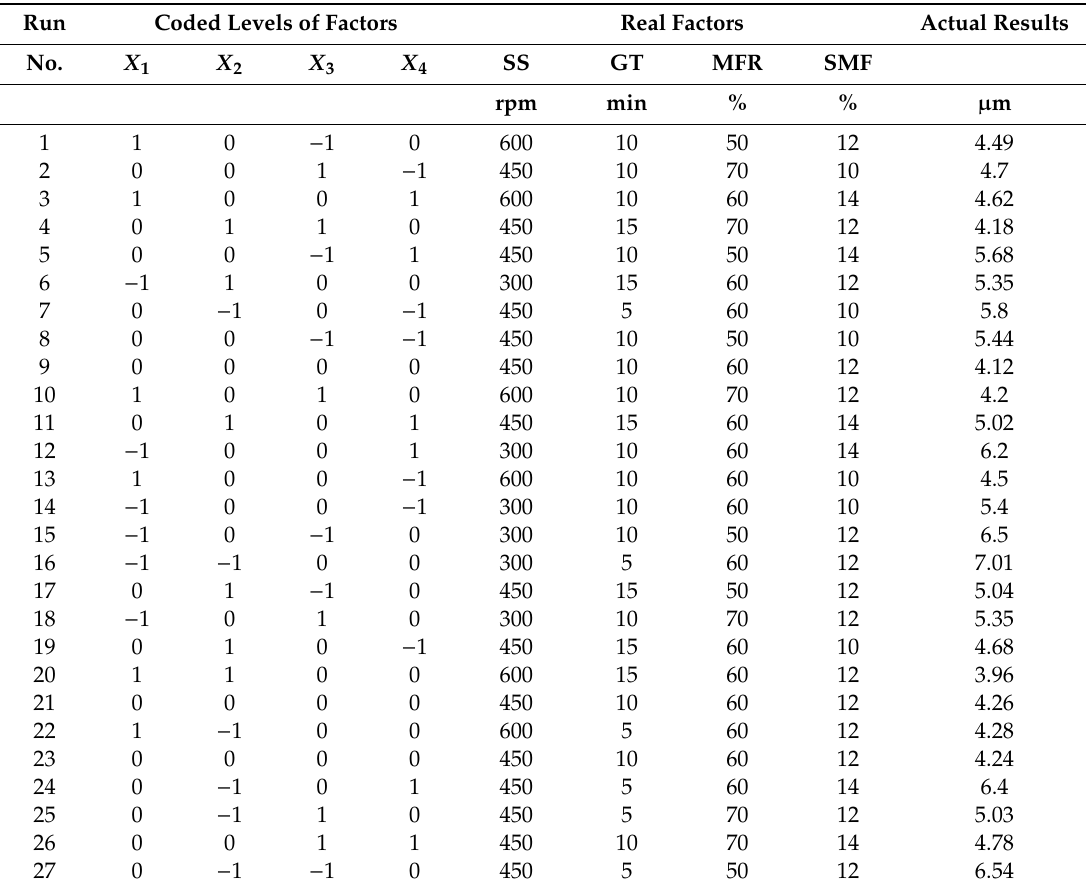
Table 3. Box-Behnken design and actual